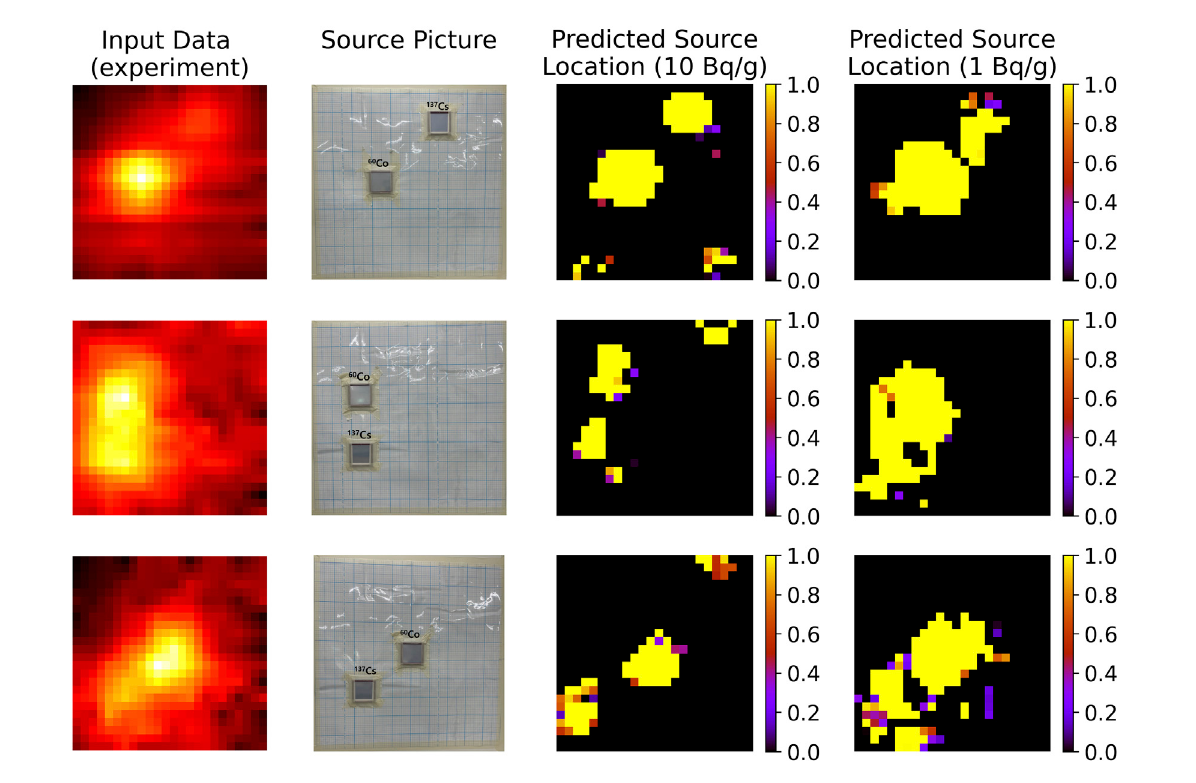
FIGURE 7 Predicted results with experimentally acquired input datasets. An image of the input dataset (Column 1), picture of the source arrangement (Column 2), and hotspot locations predicted using the model trained by scanning simulation data with concentrations of 10 Bq/g (Column 3) and 1 Bq/g (Column 4).